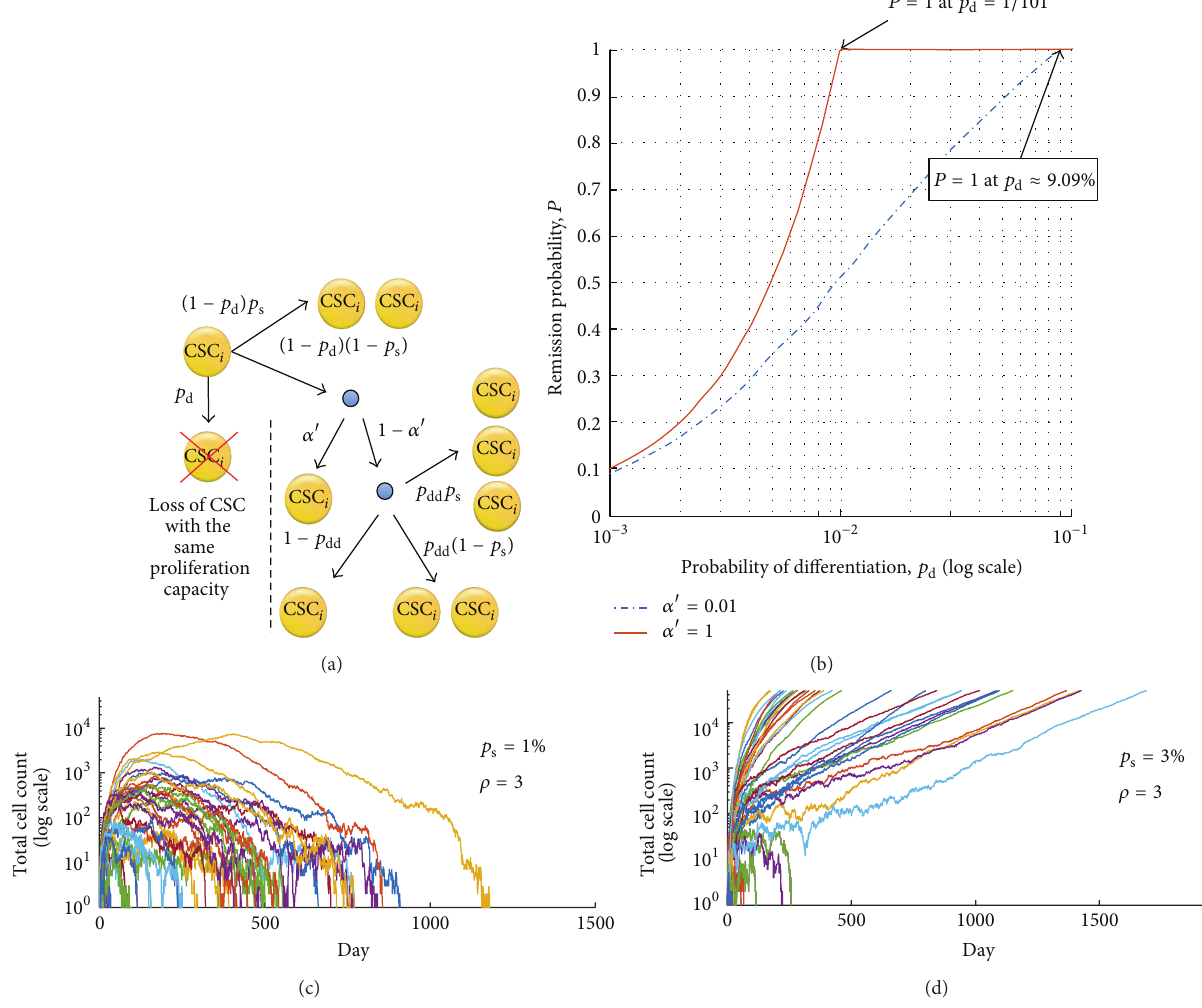
Figure 3: (a) Possible outcomes of the cancer stem cell (CSC) division when one considers survival of CSC with proliferation potential 𝑖 (CSC 𝑖 ).(b)Probabilityofspontaneoustumorremission, 𝑃 ,describedby ( A ) ,fordifferentvaluesofprobabilitythatthenonstemcancercellwill die before proliferation attempt, 𝛼 󸀠 , and plasticity event frequencies, 𝑝 d = 𝑝 dd . (c) Spontaneous remission of all 100 simulated tumors initiated with single CSC equipped with proliferation capacity 𝜌 = 3 and probability of symmetric division 𝑝 s = 1 %. (d) Spontaneous remission of 17 out of 100 simulated tumors initiated with single CSC equipped with proliferation capacity 𝜌 = 3 and probability of symmetric division = 3 𝑝 s